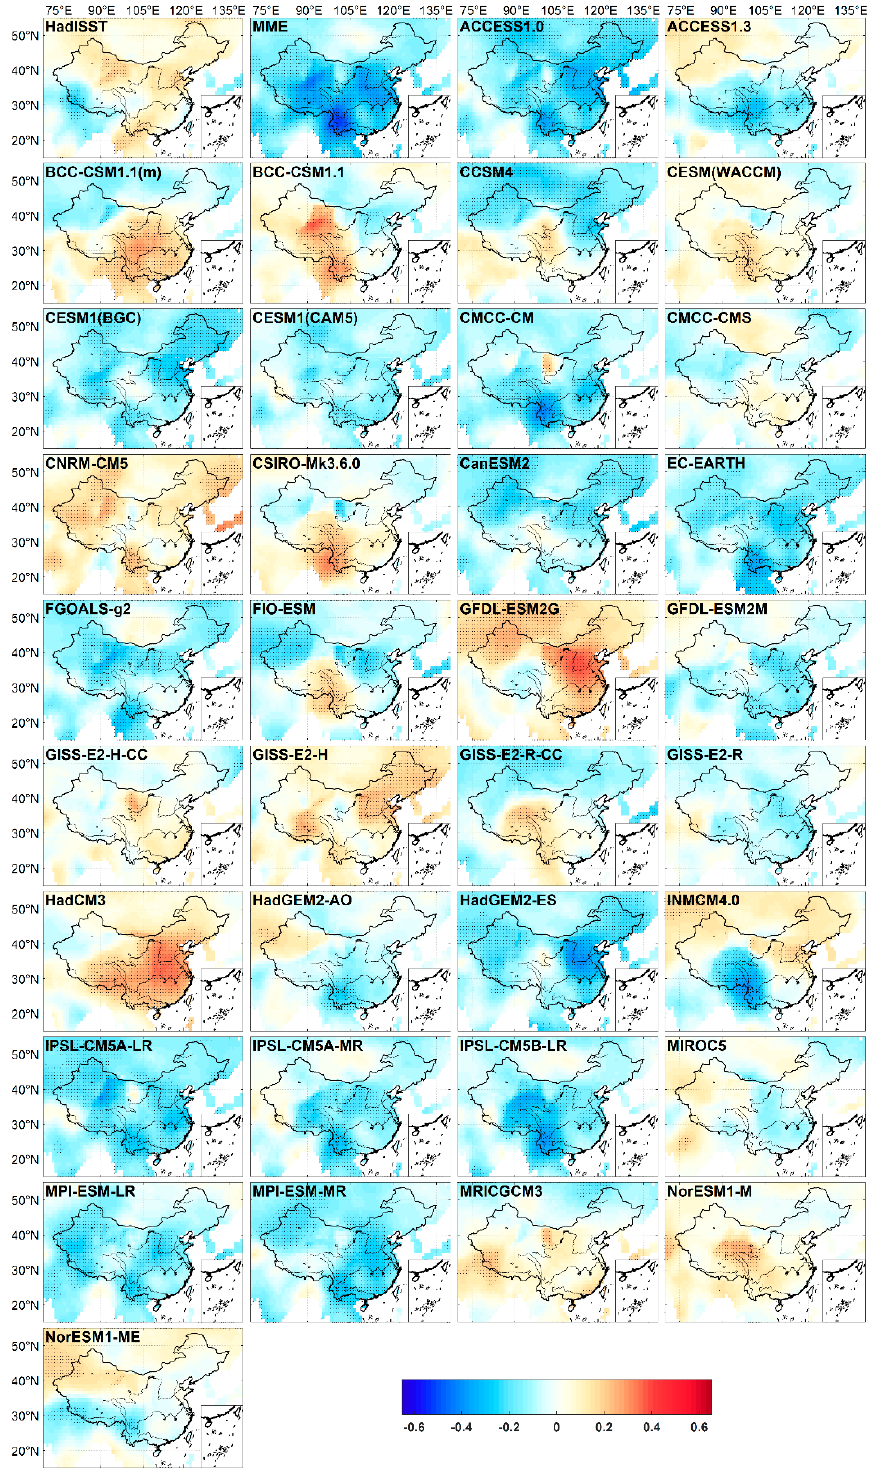
Figure 4. Correlation map of the PDO with the moving filter and China winter temperature (CWT), including results from the MME for the winter period over 1901–2005. The black points indicate that the coefficient is statistically significant at the 90% level.